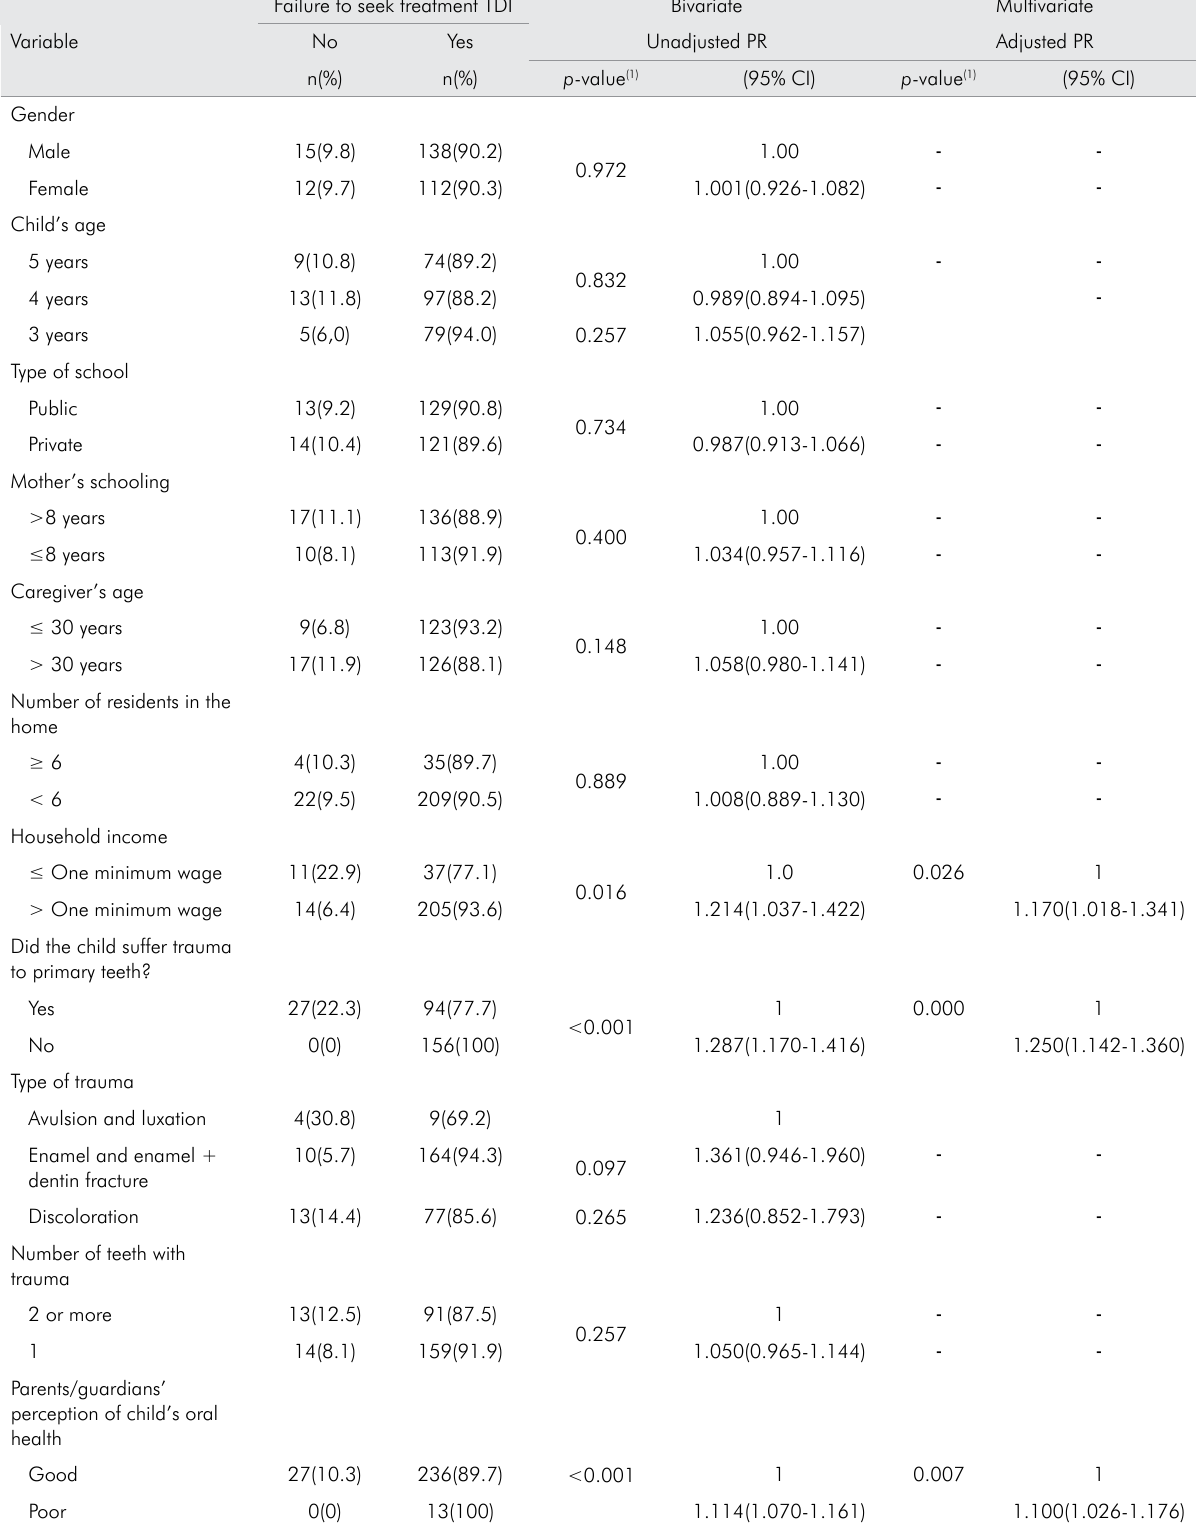
Table 3. Frequency and Poisson regression analysis according to independent variables and failure to seek treatment following TDI in preschool